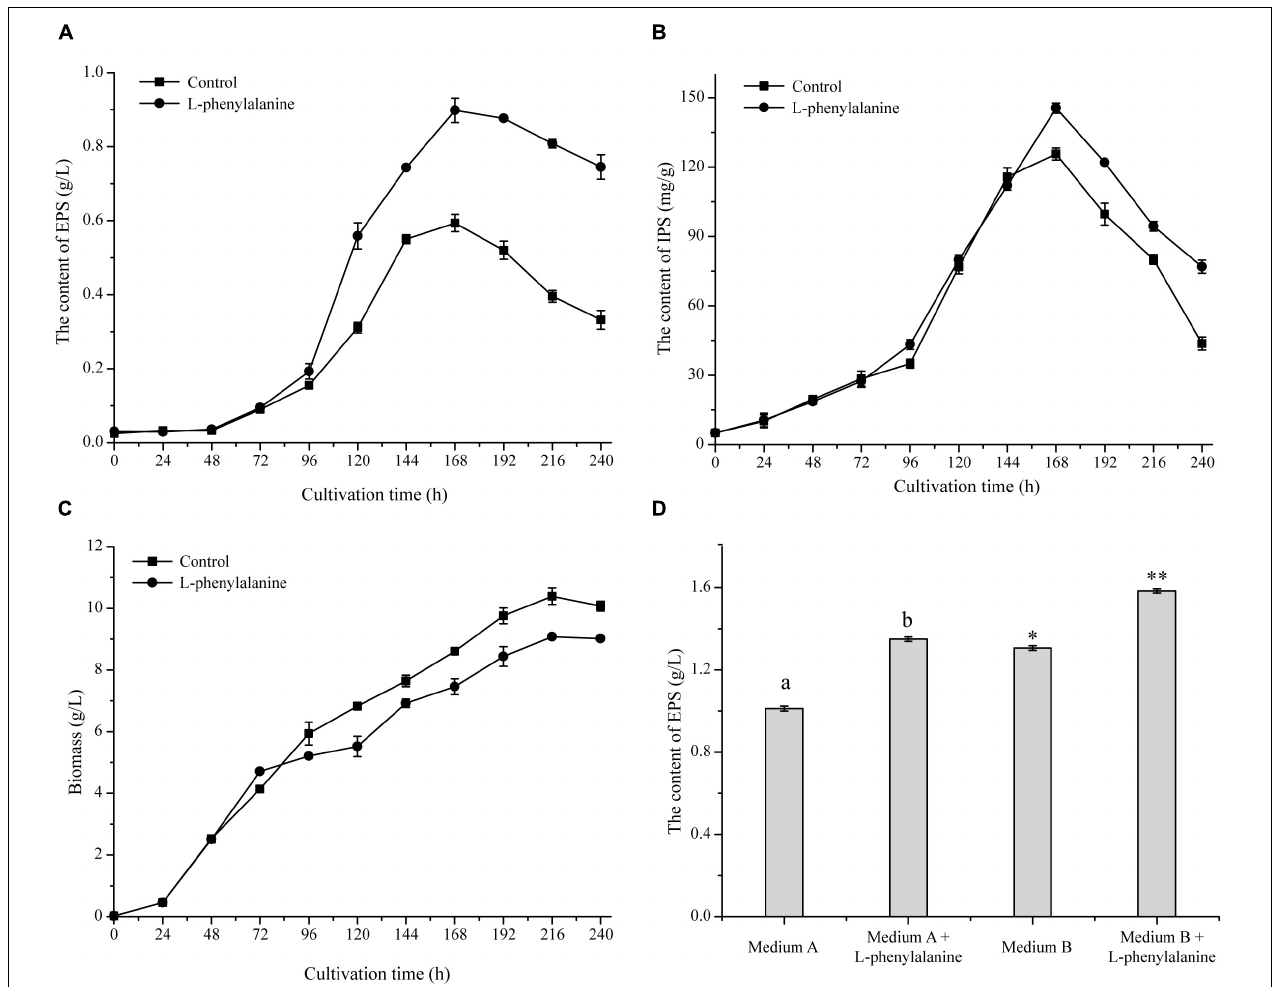
FIGURE 2 | Effect of L-phenylalanine on the yield of EPS (A) , IPS (B) , and cell growth (by biomass) (C) . (D) The effect of L-phenylalanine on the yield of EPS in different culture media [the different superscript letters (a, b) and symbols ( ∗ , ∗∗ ) in each column indicate significant differences at the P < 0.05 level].